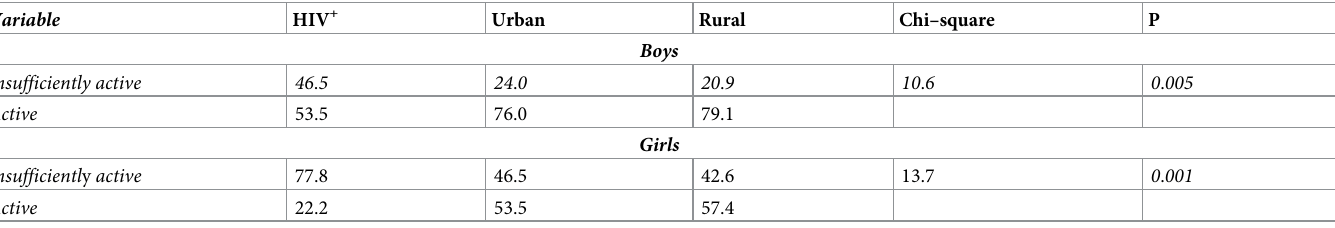
Table 6. Comparison (%) of subjects according to activity categories classified by the average number of steps per day; p values resulted from the Chi-square test.